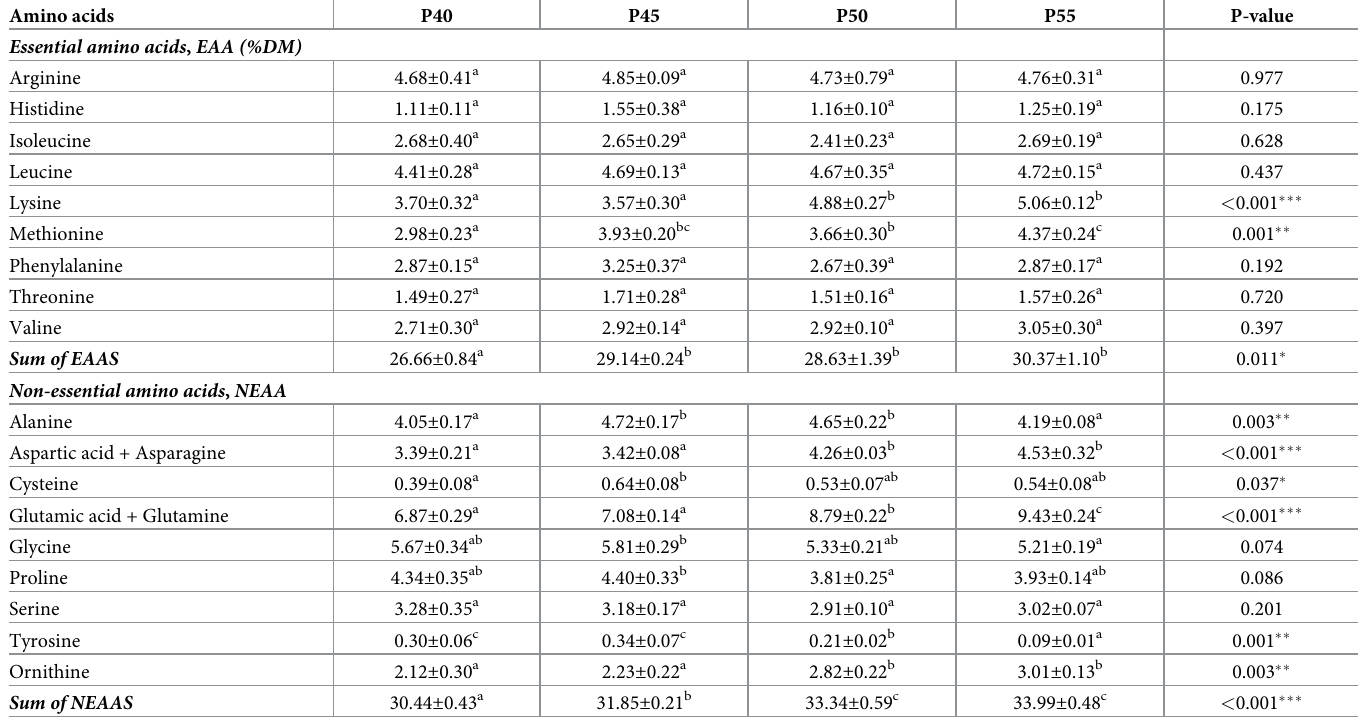
Different superscripts on the same row indicates there is a significant difference. ± SD.